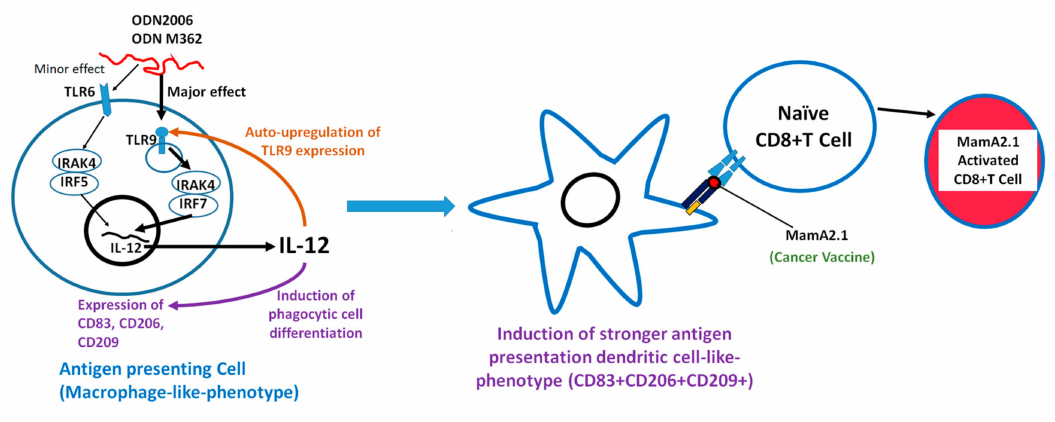
Figure 9. Possible mechanism of ODN2006 and M362 mediated TLR-6 / 9 interplay mediated by IL-12 leading to THP-1 cell di ff erentiation and phagocytic capability, resulting in antigen specific CTL